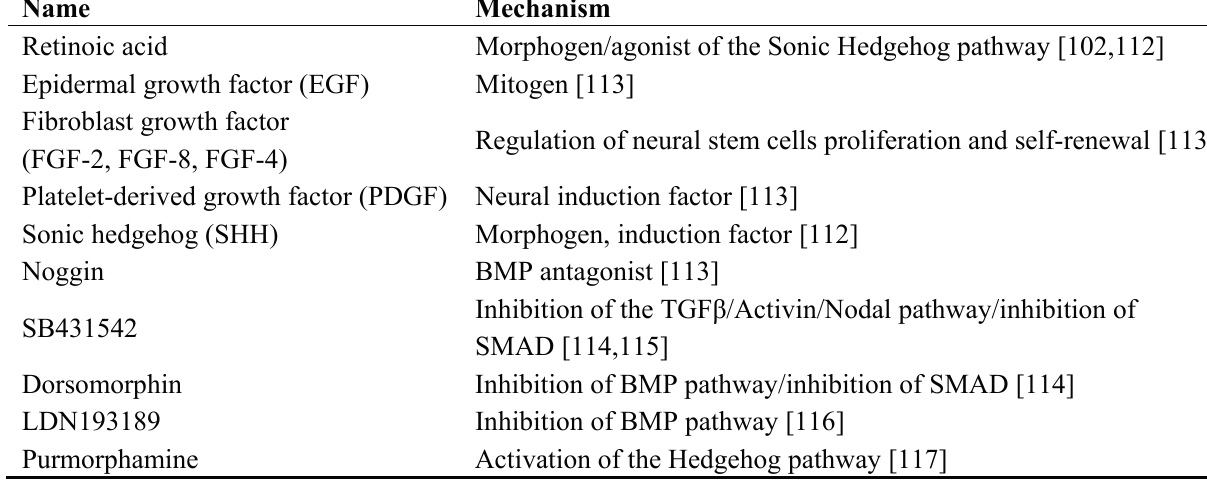
Table 4. Chemicals and small molecules used for neural